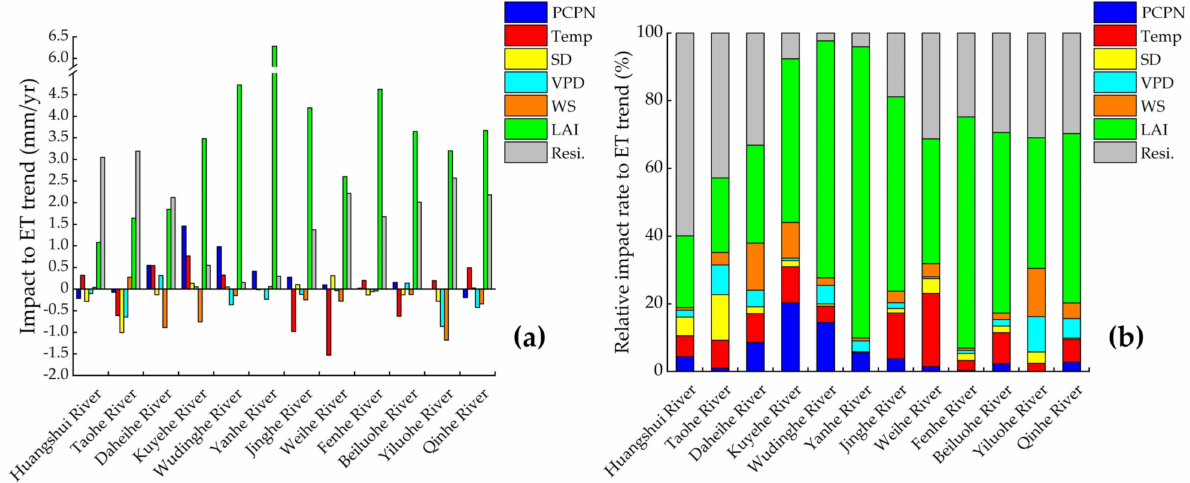
Figure 10. ( a ) Impacts and ( b ) relative impact rates of the climatic and subsurface factors on the ET trend in the different subbasins in the